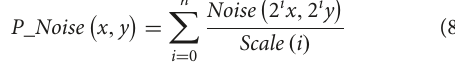
superimpositions according to the actual simulation needs, and the generated Perlin noise function is shown in Equation